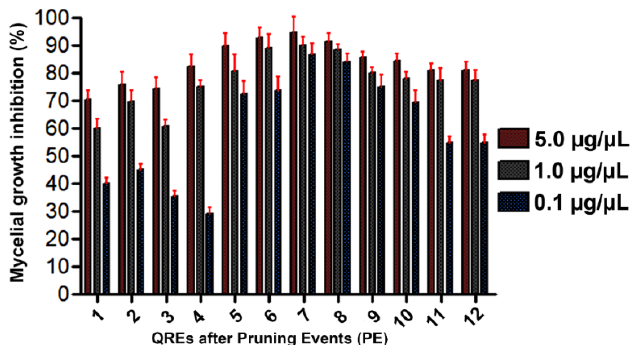
Figure 6 . Mycelial growth inhibition percentages of QREs at three concentrations after pruning events (PE1-12) on L. polyphyllus .